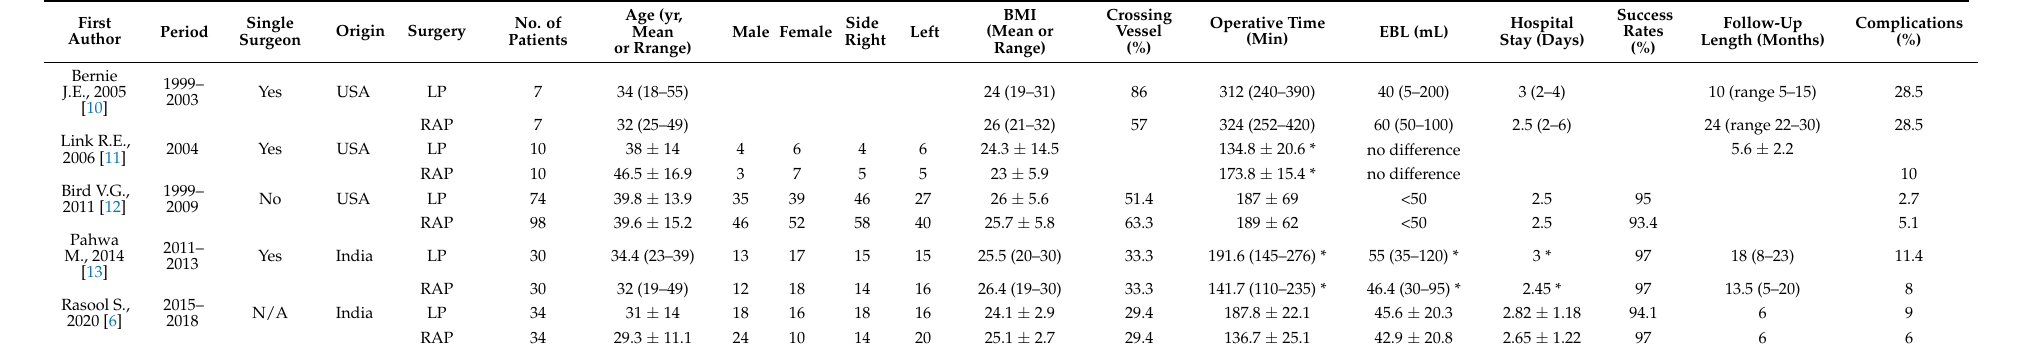
Table 3. Comparisons between laparoscopic pyeloplasty and robot-assisted pyeloplasty in the adult population, as reported in the